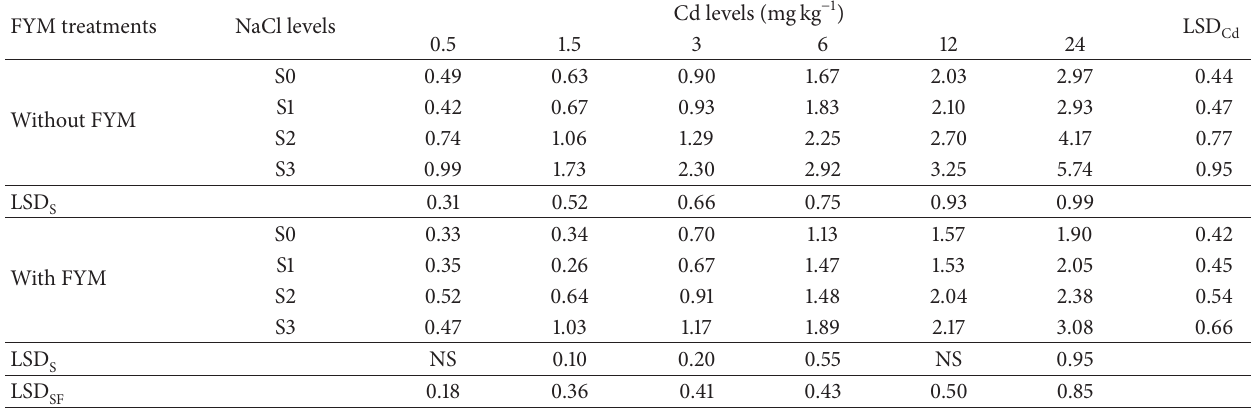
Table 3: Treatment effects on shoot Cd content (mg kg − 1 ) of barley plants. FYM